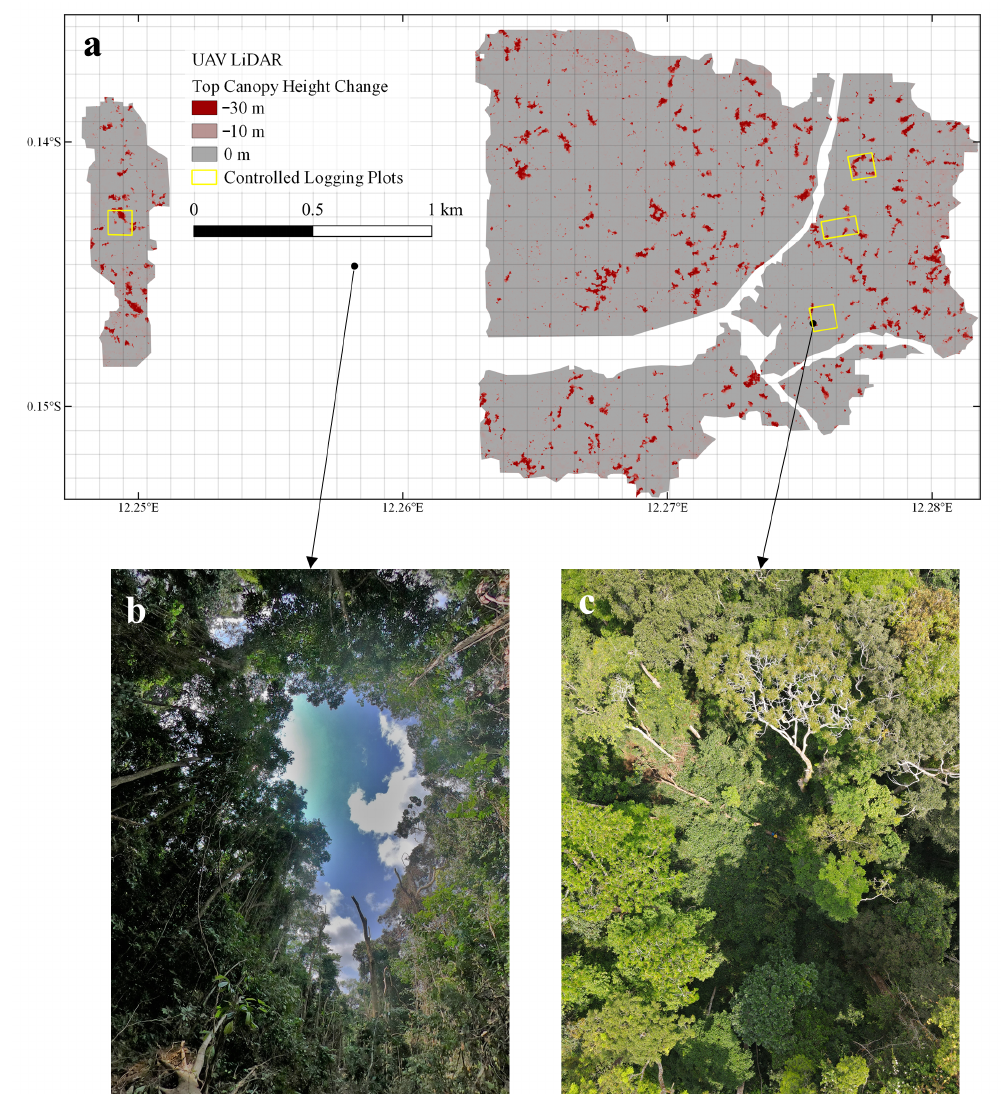
Figure 2. Canopy gaps caused by selective logging at our study site in Ivindo, Gabon. ( a ) UAV LiDAR Top Canopy Height Change between January 2020 and January 2021 shows losses from controlled logging plots (yellow boxes) and reduced-impact logging of the surrounding area; ( b ) view of a canopy gap from below, taken less than 1 month after the disturbance; ( c ) view of a canopy gap from above, taken 1 year after the disturbance. Arrows from ( a ) indicate locations of photos in ( b , c